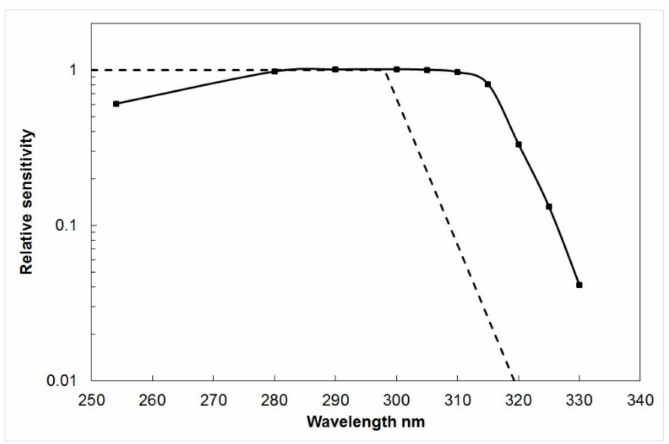
Figure 2. The spectral sensitivity of PSP film (solid curve) [4] and the erythema action spectrum (broken curve)